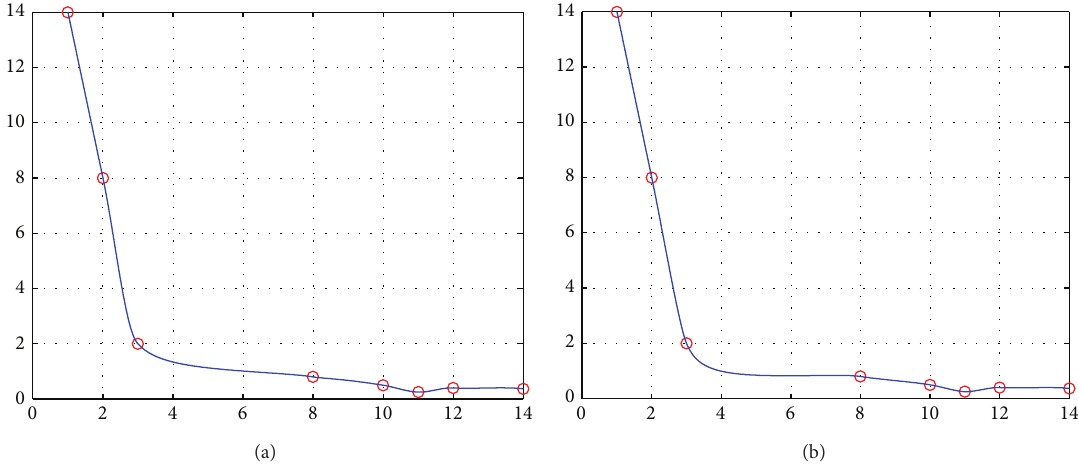
Figure 7: Comparison between our positivity-preserving interpolation spline curves (on the left) and the positivity-preserving interpolation spline curves given in [26].